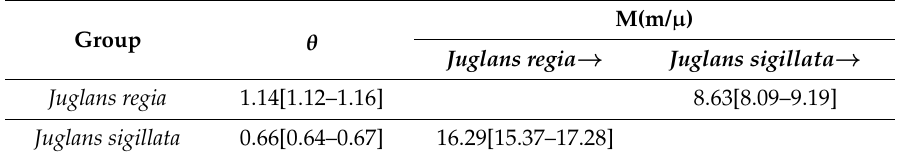
Table 4. Historical gene flow as estimated by Migrate 3.6.4 among Juglans regia and J. sigillata .